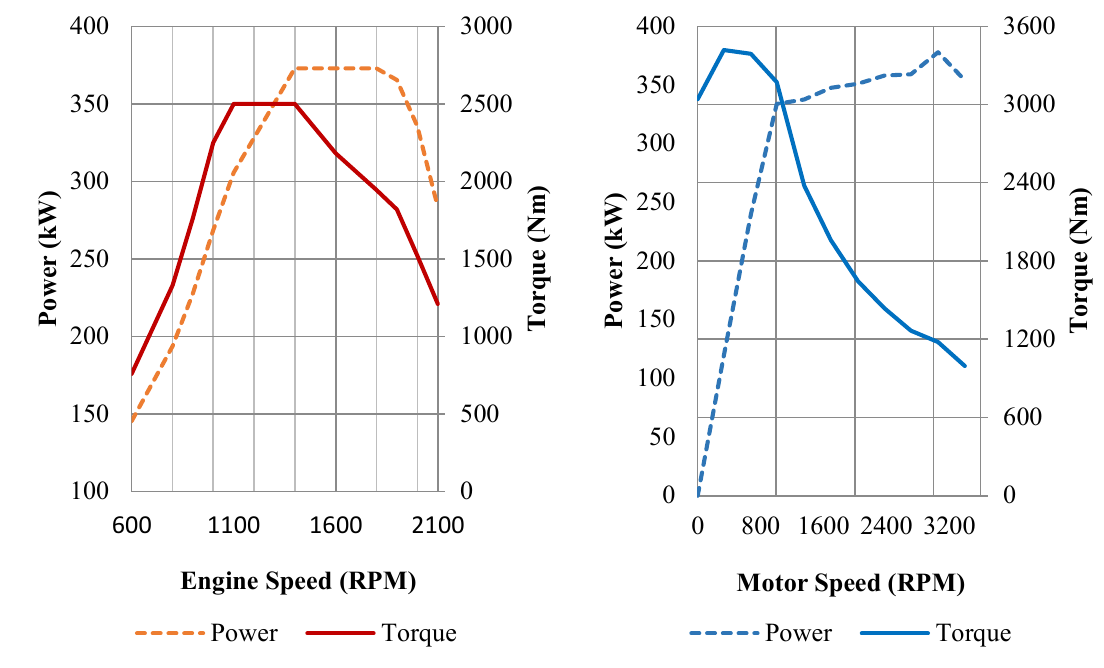
Figure 8. Right: diesel engine map; left: electric motor map.